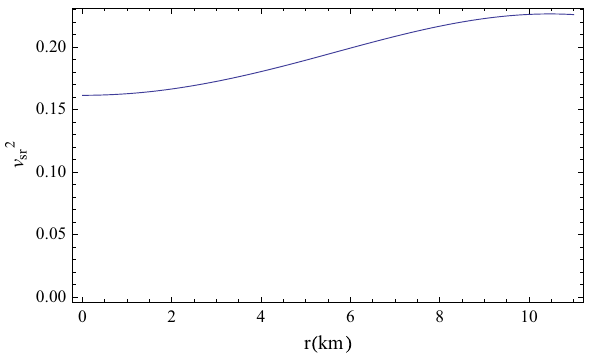
Fig. 12 Variation of the mass function at the interior of a stellar object with r for PSR J0348+0432 with β = 1 and β 1 =